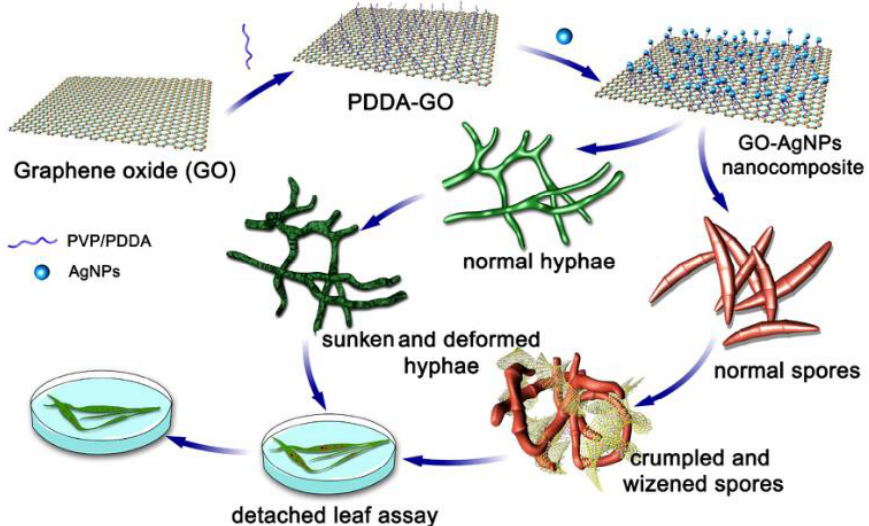
Figure 8. Schematic diagram of the preparation of graphene-AgNPs nanocomposites and their antifungal properties in vitro and in vivo. (Printed image with permission from Ref. [122], copyright 2016, American Chemistry Society).